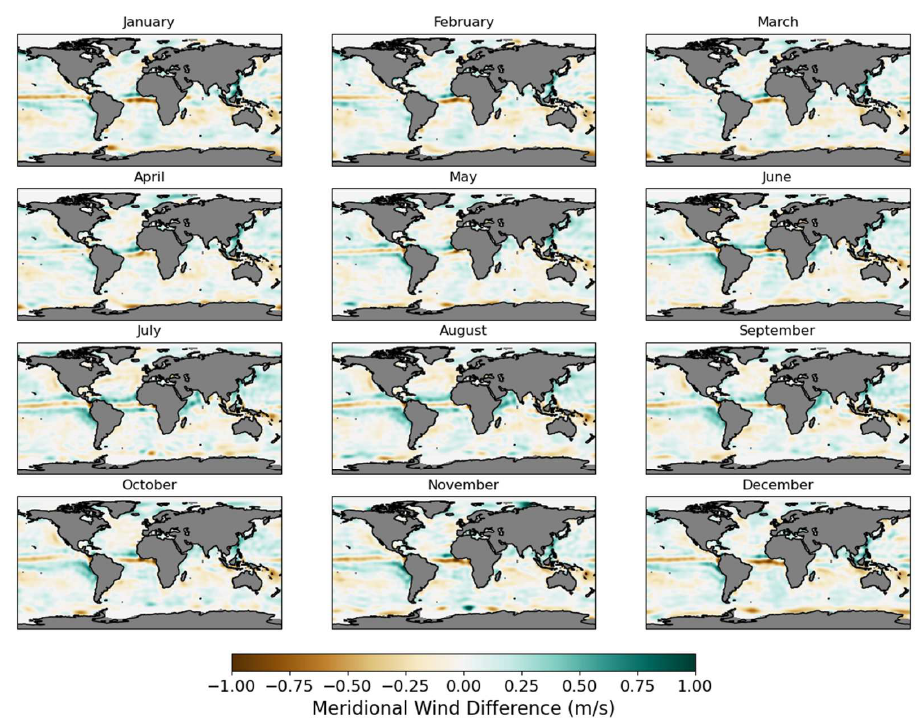
Figure A2. Months of monthly meridional wind adjustments applied to speed-adjusted ERA5